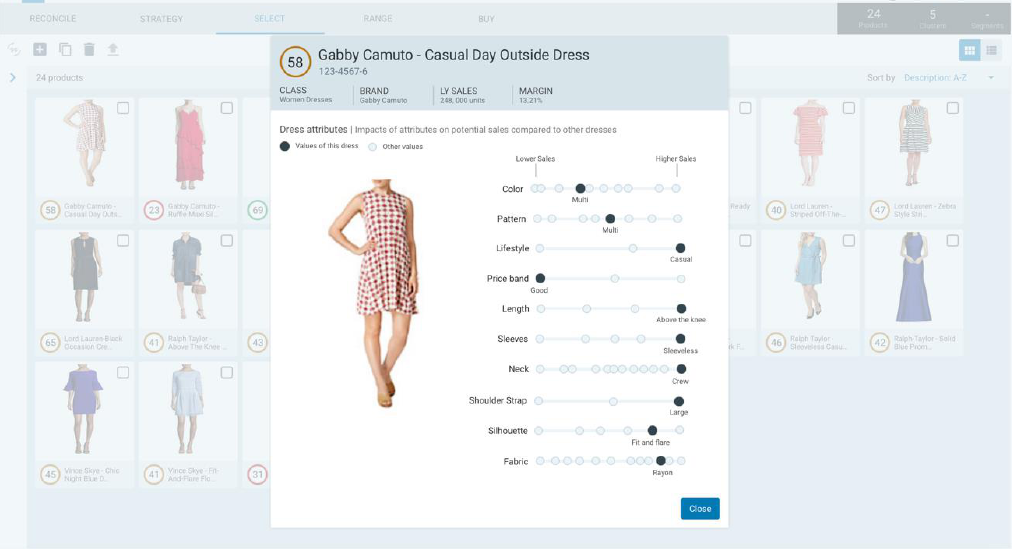
Figure 3. Modal window for each product of task 2 (T2).